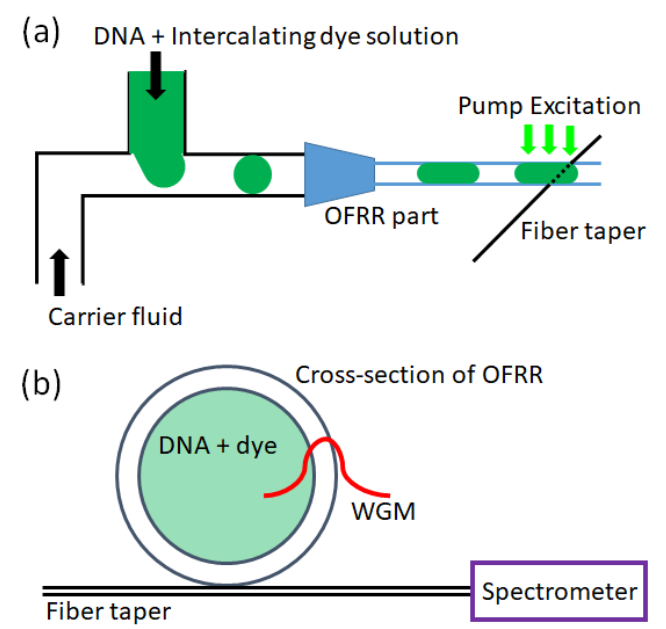
Figure 1. ( a ) Schematic of microfluidic system for DNA/dye microdroplet generation and optofluidic ring resonator (OFRR) laser experiments downstream. ( b ) When the microdroplets passing the glass capillary OFRR are optically pumped, the DNA/dye gain interacts with light confined in the WGM in the evanescent field, providing enough feedback for laser emission. The optical signal, excluding undesired fluorescence background, is coupled into a fiber taper and collected using a spectrometer at distal